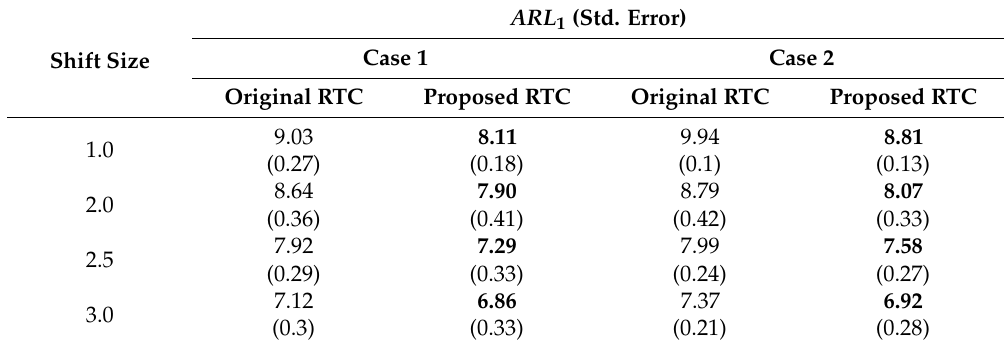
Table 2. Experimental results, dimension size = 10, window size = 10.